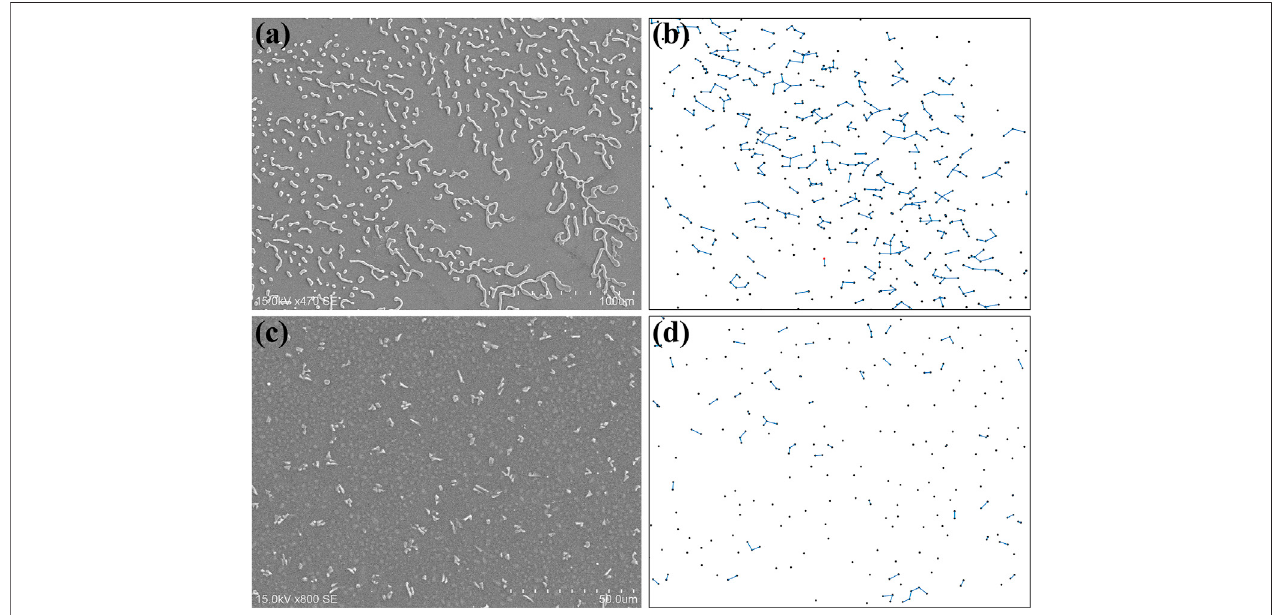
FIGURE 3 | (A) The SEM image of the surface pattern and (B) the simulated growth scenario of fractal structure under positive corona discharge; (C) The SEM images of the surface pattern and (D) the simulated growth scenario of random structure under negative corona discharge.